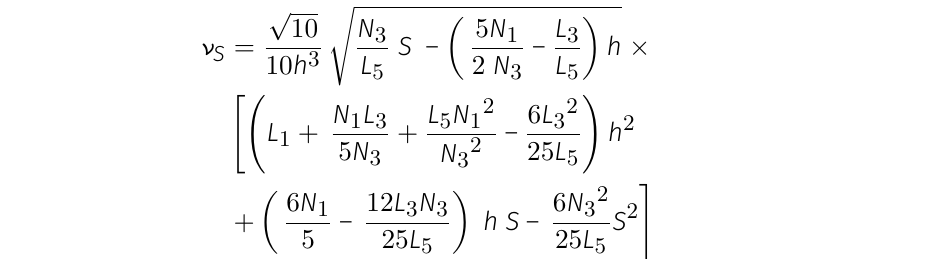
Figure 6. shows a grayscale map for the ∆Ω∆Ω∆Ω normalized waveform behavior as the dimensionless time τττ and depth hhh vary. In this map the widest and deepest water vacancies are represented by the darkest shades and they occur in large scale in deep waters ( h (cid:29) h d ≈ 2 . 1 h (cid:29) h d ≈ 2 . 1 h (cid:29) h d ≈ 2 . 1 ). It is also noted that in intermediate waters ( h ≈ 1 h ≈ 1 h ≈ 1 ), the hole soliton shape is well defined, and as this waveform reaches shallow water it becomes narrower and it disappears as h (cid:28) h s ≈ 0 . 28 h (cid:28) h s ≈ 0 . 28 h (cid:28) h s ≈ 0 . 28